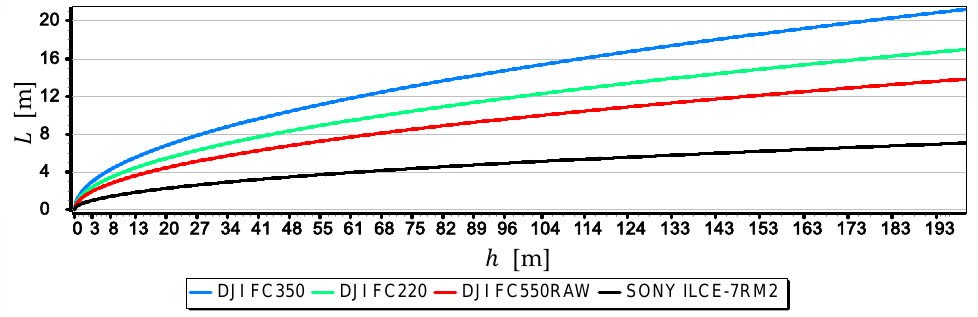
Figure 8. Single-pixel measurements resolution 𝐿 of the horizon line as a function of the height of the camera a.s.l. ℎ .